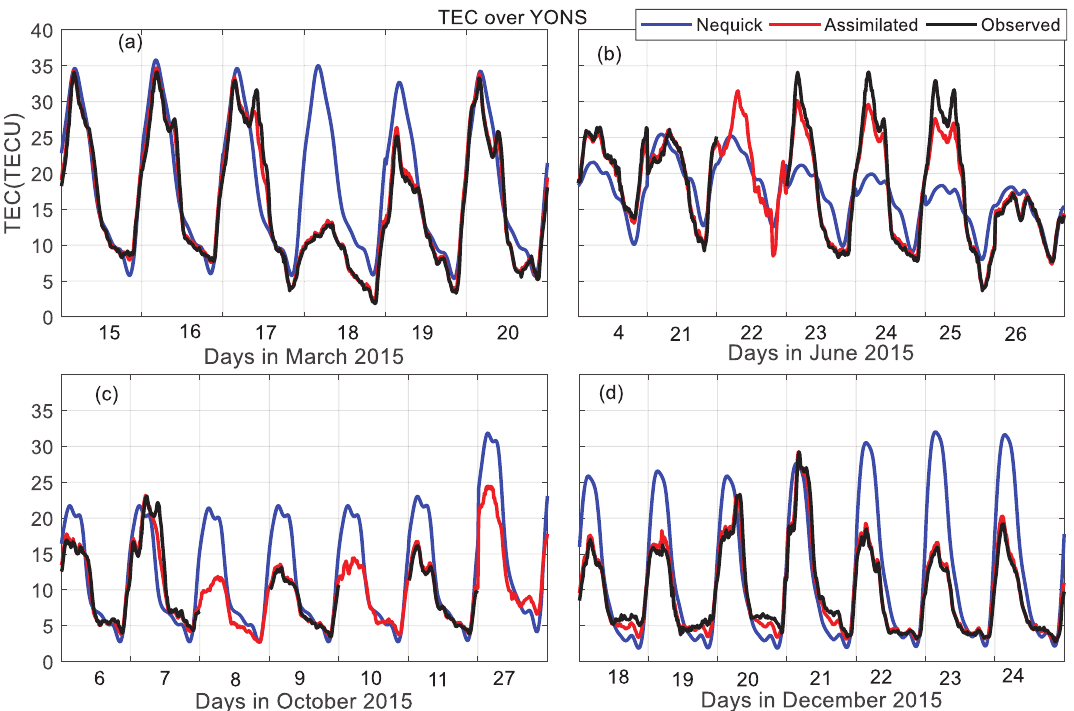
Figure 5. Panels (a), (b), (c), and (d) present variation of TEC during March 15 – 20, June 4, 21 – 26, October 6 – 11, 27, and December 18 – 24, 2015, respectively over YONS. The blue, red, and black colors represent NeQuick model generated parameter, assimilation result, and observed